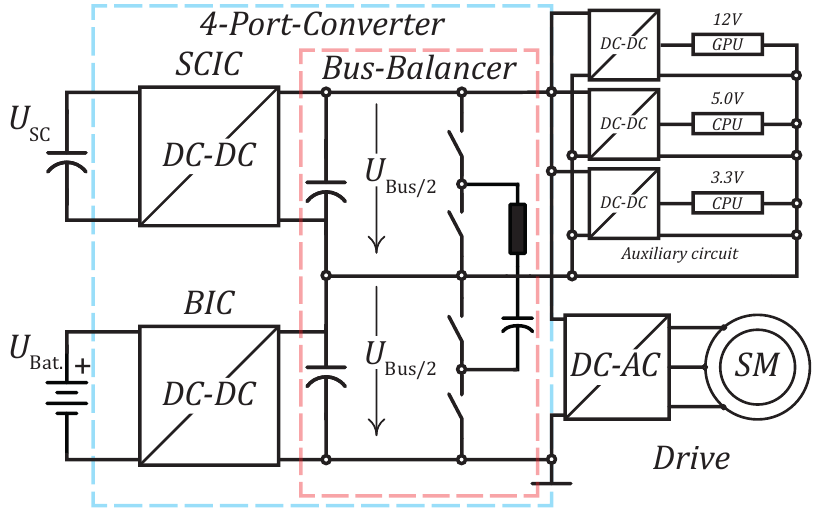
Figure 11. Topology VII: Combining the battery and the super-capacitor module.